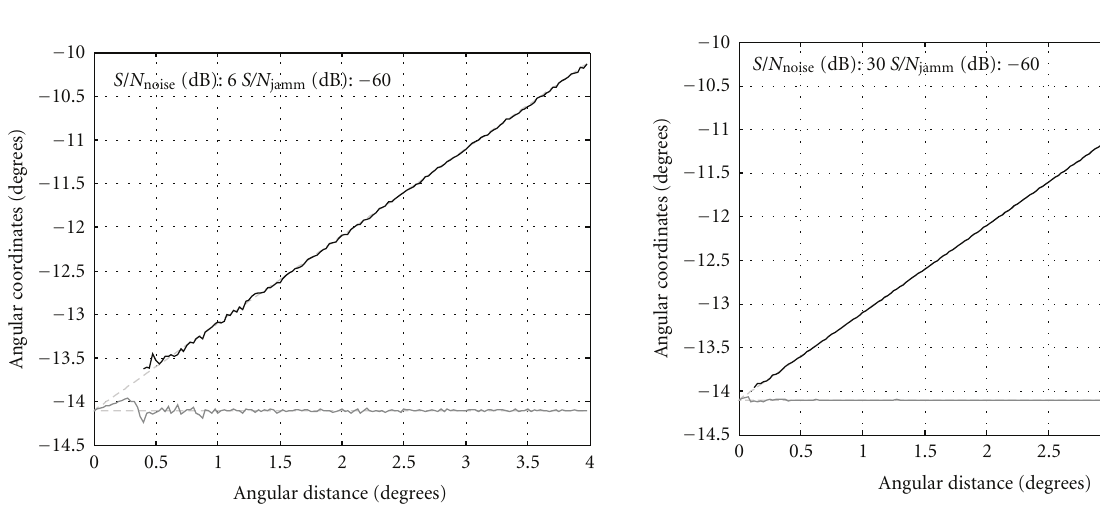
Figure 12: Histogram of polar coordinates evaluated by using the TLS ESPRIT method at S/N noise = 30 dB and S/N jamm = − 60 dB.